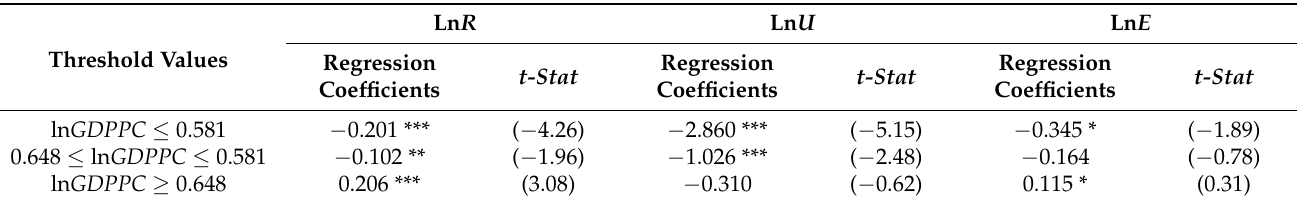
Table 4. Estimation results of threshold